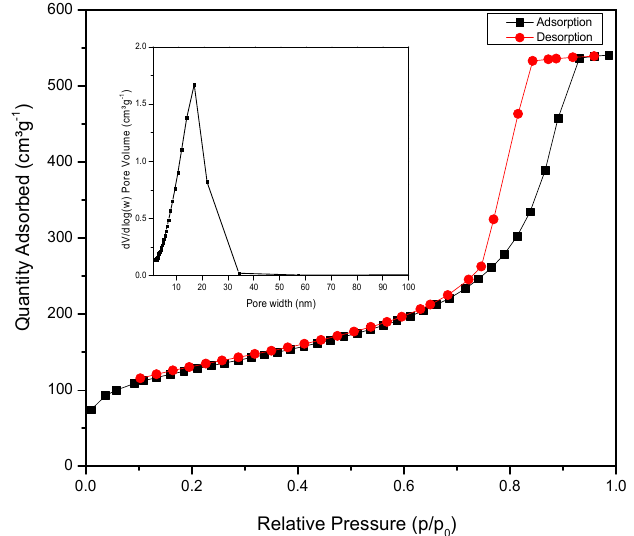
Figure 3. Nitrogen sorption isotherms and pore size distribution of synthesised RF/TiO 2 gel.